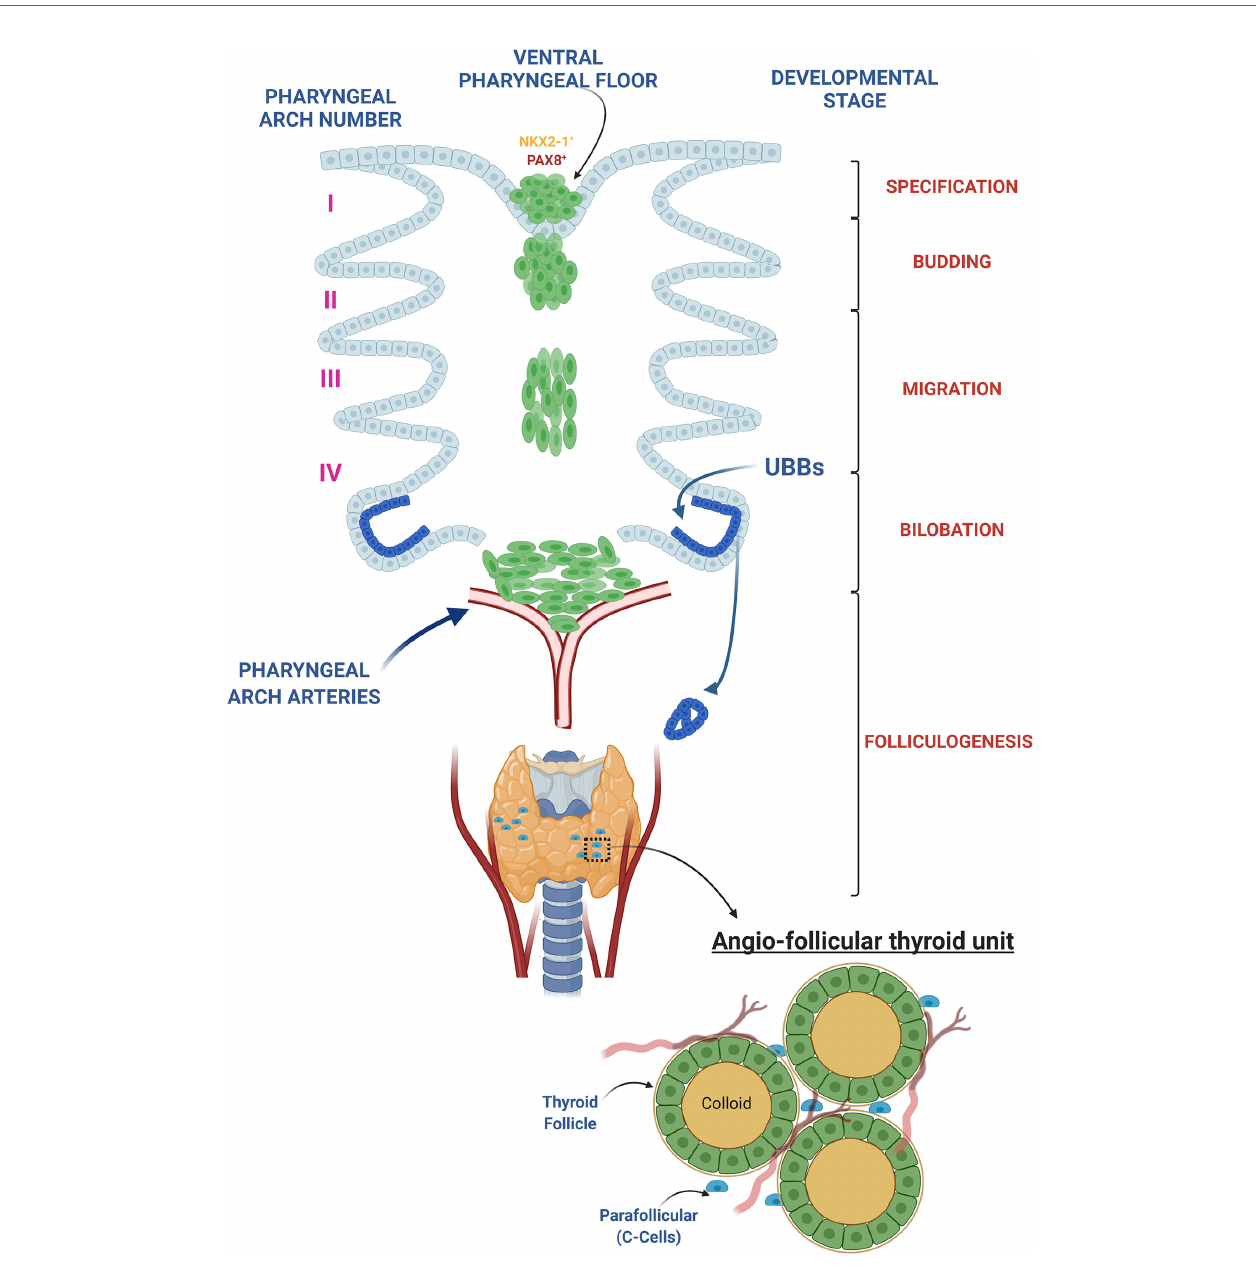
FIGURE 1 | Thyroid development overview. The thyroid morphogenesis in mice can be divided in 5 different steps: 1. Thyroid speci fi cation: occurs in the de fi nitive endoderm-derived gut tube at embryonic day (E) 8.5 in mice and day post fertilization (DPF) 20-22 in human and is characterized by a thickening of a restricted area of the pharyngeal endoderm within the anterior ventral foregut epithelium, caudal to the fi rst branchial branch, called the placode. The resulting foregut endoderm derived cells in the placode upregulate Nkx2-1 and Pax8 , the earliest known gene markers of “ thyroid speci fi cation, ” and represent the small pool of endodermal primordial thyroid progenitors from which the entire adult thyroid follicular epithelium will derive. 2 . Budding: a progressive increase in thickness of the placode determines an evagination of the pharyngeal endodermal tissue, fi rstly visible at day E9.5 in mice and DPF 24 in human. 3. Migration: at E10-10.5 in mice and DPF 26 in human, the thyroid primordium begins its migration to pretracheal position. At the moment of detachment, the thyroglossal duct degenerates, leaving the thyroid bud completely surrounded by mesenchymal tissue, losing any contact with the fl oor of the pharynx. 4. Bilobation: the earliest signs of the bilobation can be observed at E11.5 in mice, when the thyroid shape changes from spherical to oval but it is only at E12.5 in mice that the thyroid extends bilaterally along the third pharyngeal arch arteries reaching its de fi nitive shape. In human the bilobation takes approximately 20 days, from DPF 28 until DPF 48. During this process the thyroid primordium fuses with paired ultimobranchial bodies (UBB), lateral anlagen originating from the fourth pharyngeal pouches, designated to a C-Cell (calcitonin- producing cell) fate. 5. Folliculogenesis: once the bilobation is complete, the thyroid undergoes folliculogenesis. During this process, from E14.5 to E17.5 in mouse and from DPF 60 to DPF 84 in human, thyroid follicular epithelial cells (thyrocytes) acquire epithelial polarity and the follicular lumen gradually grows, resulting into the fi nal shape of the follicle. Vascularized, polarized follicles comprise the functional and morphological thyroid unit, namely the angio-follicular thyroid